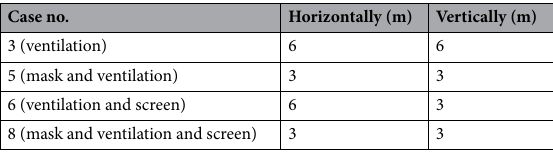
Table 4. Recommended social distance on cases with upward